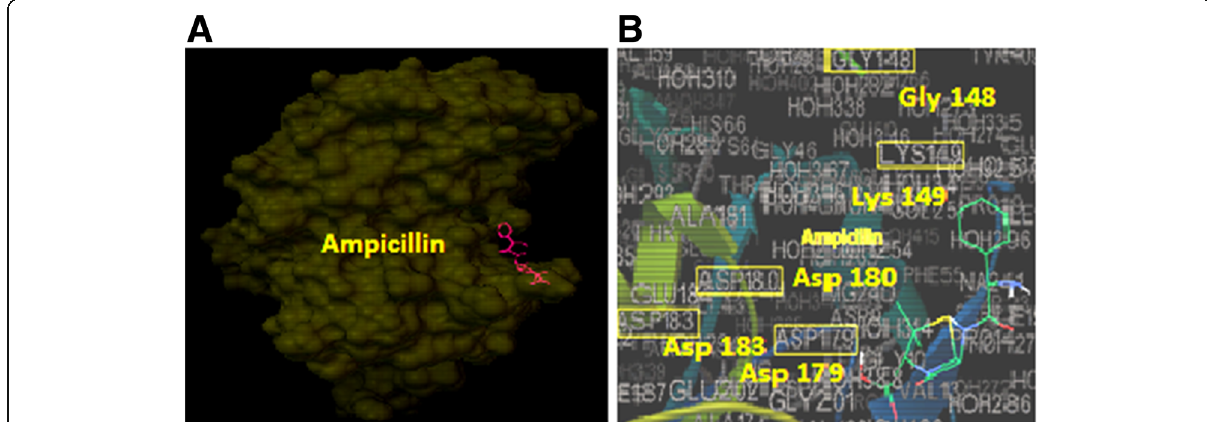
Fig. 10 a , b Docking pose of model TPP with